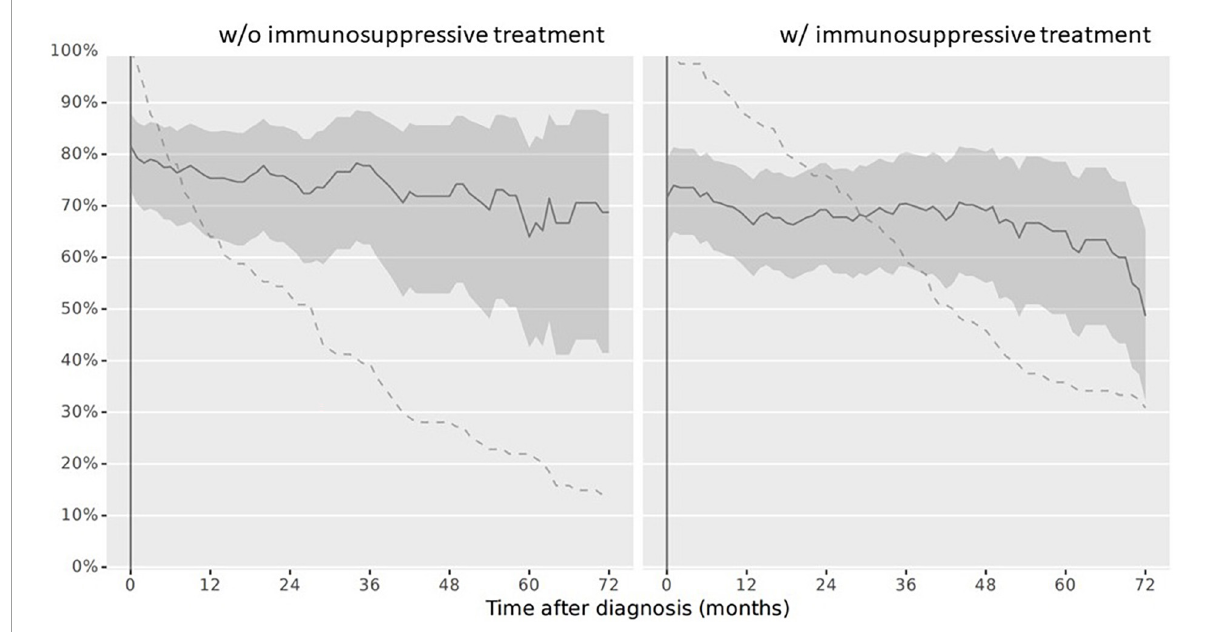
FIGURE3 Complete vaccination status according to the Swiss national vaccination schedule in children after PRD diagnosis. Legend: y-axis Completeness (% patients vaccinated completely, solid line with 95% confidence interval), x-axis Sample size (% patients available, dashed line). Abbreviation: PRD pediatric patients with rheumatic inflammatory diseases. w/o, Without immunosuppressive treatment w/ with immunosuppressive treatment.